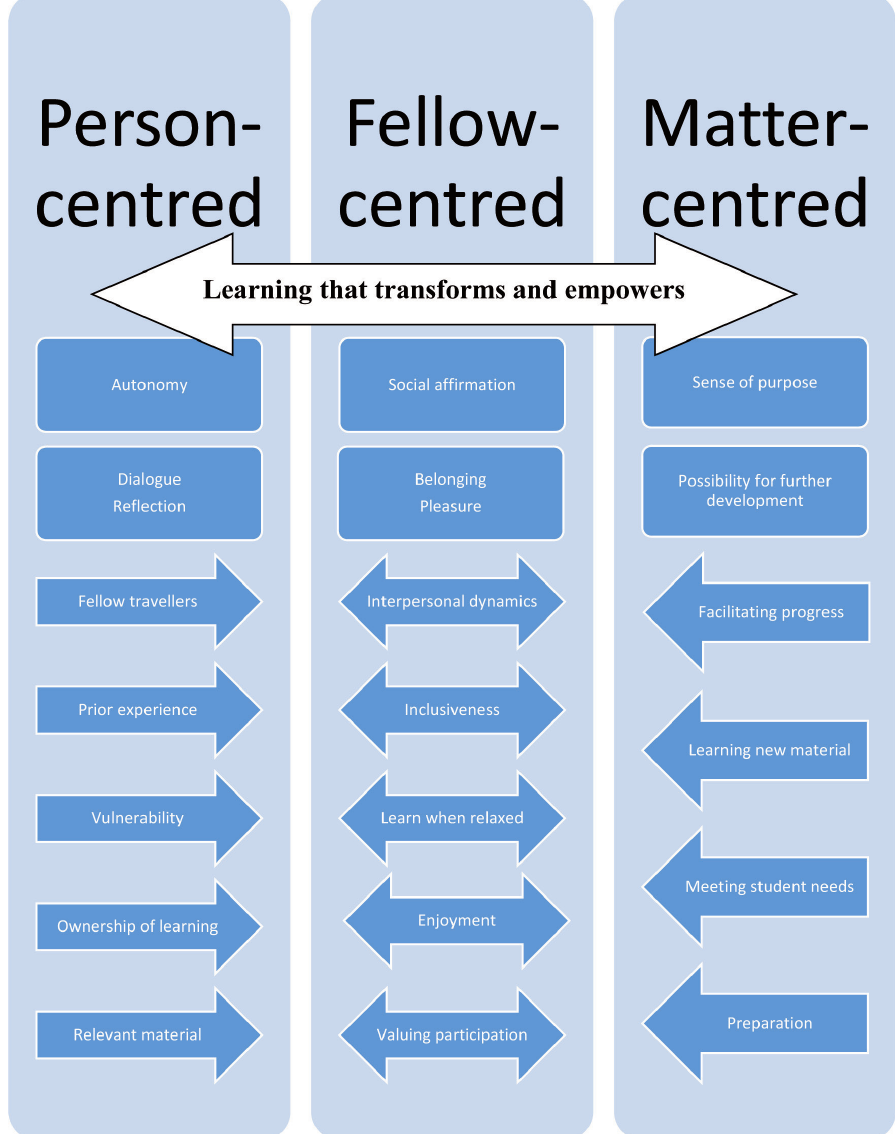
Figure 2: Themes organized in relation to the theoretical